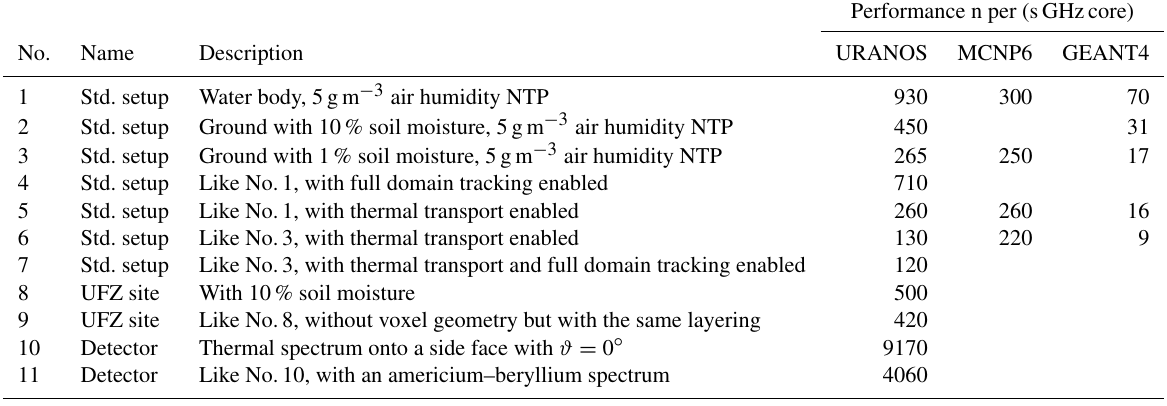
Table 4. Benchmark results for the single core performance of URANOS (v0.99 ρ ) and MCNP for a number of practically relevant scenarios.